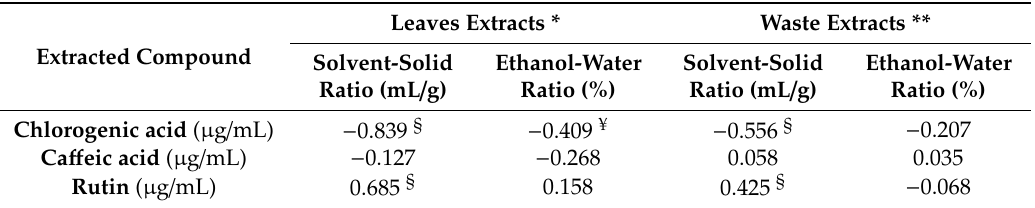
Table 6. Correlations between ethanol-water ratios and solvent-solid ratios and bioactive compounds. Leaves Extracts * Waste Extracts ** Extracted Compound Solvent-Solid Ethanol-Water Solvent-Solid Ethanol-Water Ratio (mL / g) Ratio (%) Ratio (mL / g) Ratio (%) Chlorogenic acid ( µ g / mL) − 0.839 § − 0.409 ¥ − 0.556 § Ca ff eic acid ( µ g /